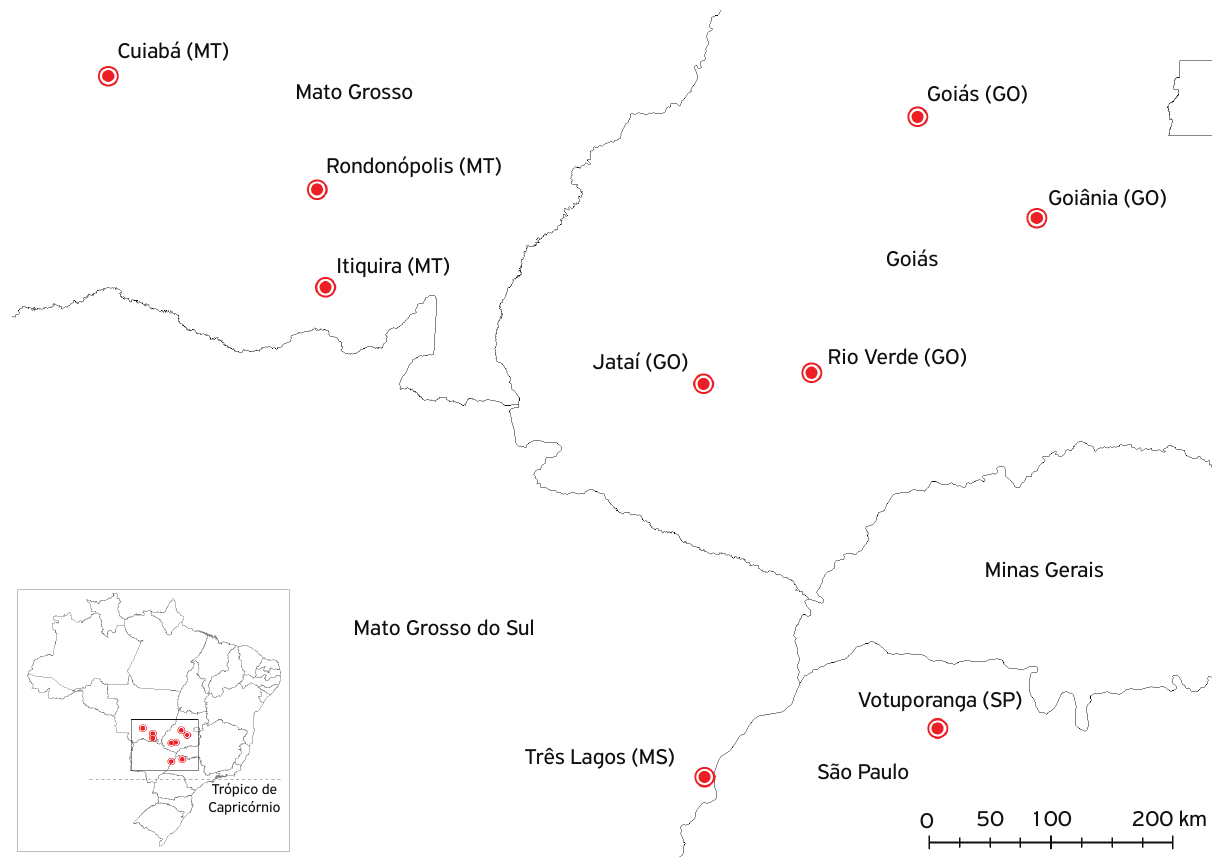
Figura 1. Localidades avaliadas das regiões de escape do mal das